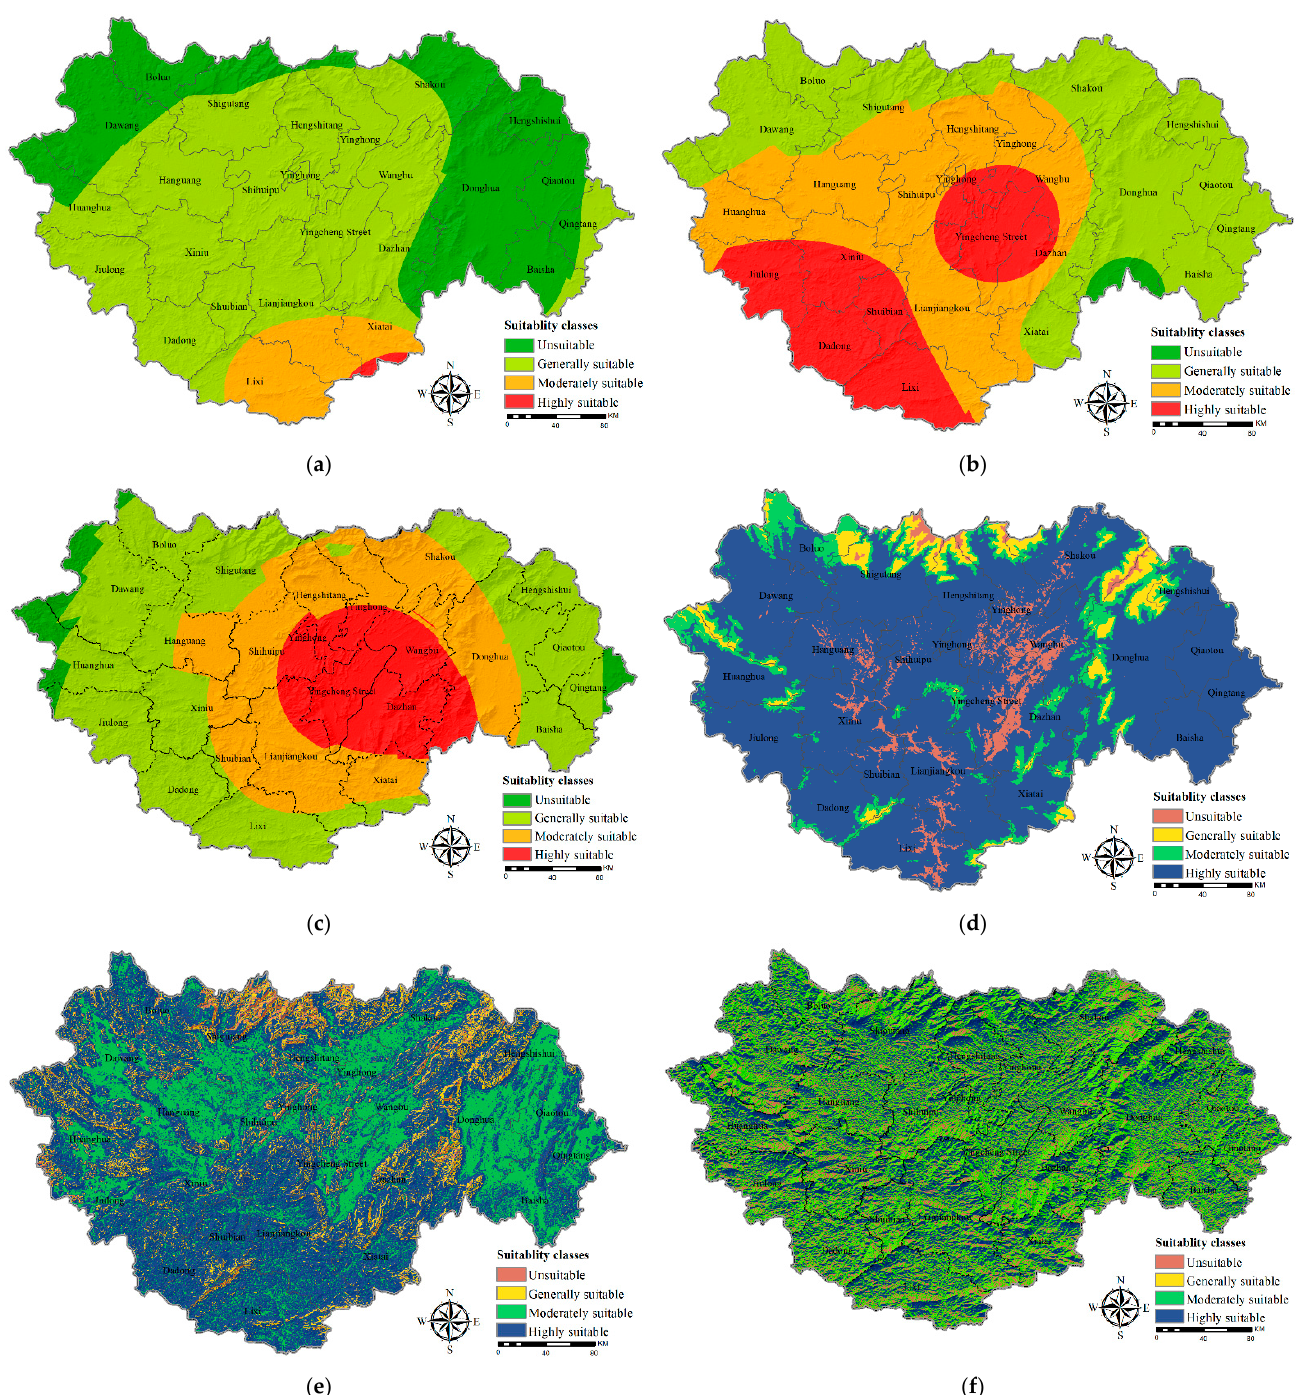
Figure 4. Suitability classes for individual factors of climate and topography (( a ) is precipitation, ( b ) is temperature, ( c ) is sunshine, ( d ) is elevation, ( e ) is slope, ( f ) is aspect). Table 6. Single-factor suitability class proportion statistics for tea cultivation (%).